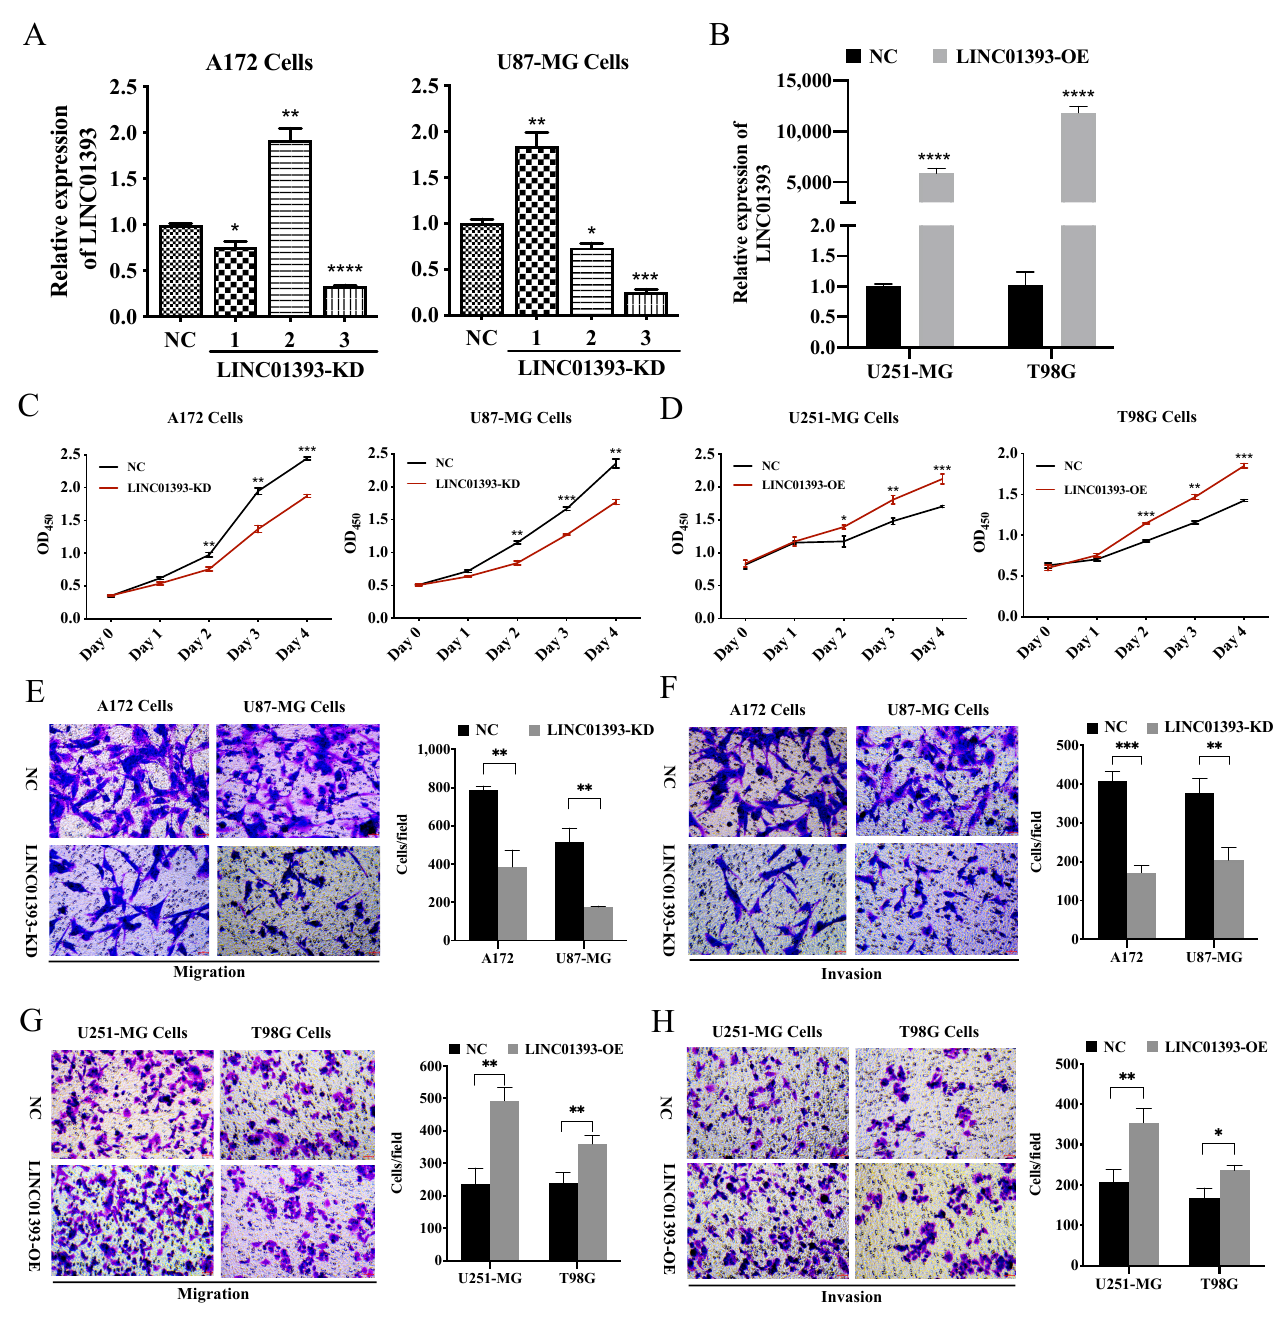
Figure 4. Effects of LINC01393 on proliferation, migration, and invasion of GBM in vitro. ( A , B ) Transfection efficiency of LINC01393 is analyzed using qRT-PCR in GBM cells. A172 and U87-MG cells are selected for LINC01393-KD, and U251-MG and T98G are selected for LINC01393-OE. ( C , D ) CCK-8 assays to assess the proliferation rate of LINC01393-KD ( C ) or OE ( D ). ( E – H ) Transwell migration and Matrigel invasion assays are used to measure the migration and invasion ability of GBM cells with LINC01393-KD ( E , F ) and LINC01393-OE ( G , H ). Representative staining images are presented (Scale bar = 50 µ m). All data are represented as mean ± SEM of 3 independent experiments. * p < 0.05; ** p < 0.01; *** p < 0.001; **** p < 0.0001, relative to